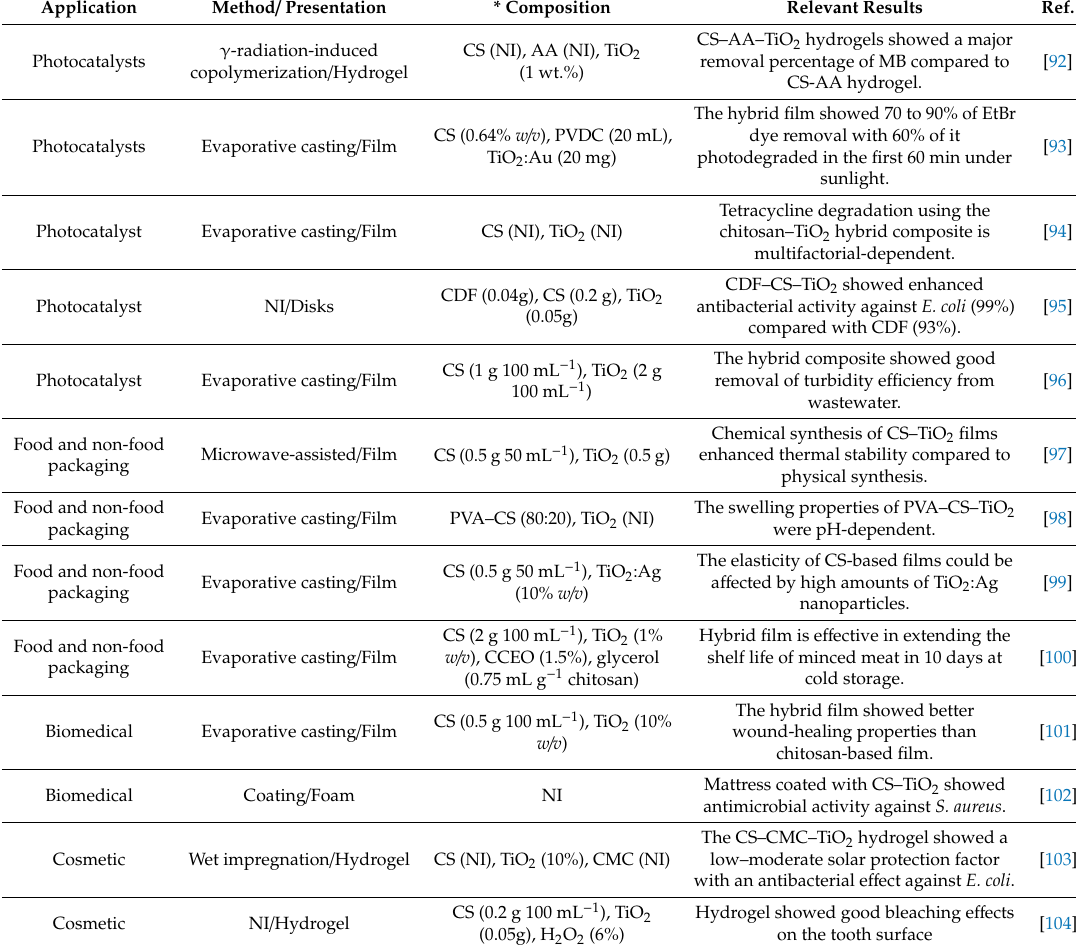
Table 4. E ff ect of TiO 2 incorporation on chitosan-based materials